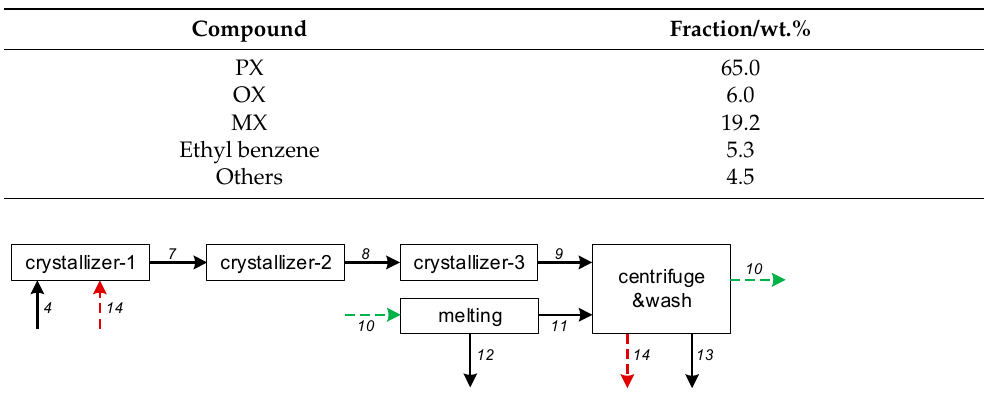
Figure 13. The solving sequence of models and the tear streams (10 and 14), where the numbers are the streams in Figure 2. Table 4. The composition of feed introduced to crystallizers in a practical industrial process.